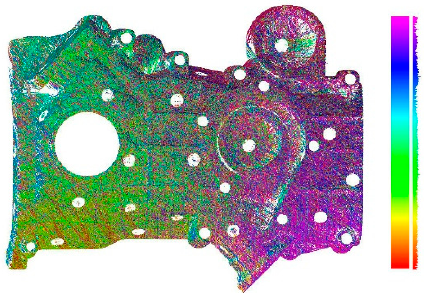
Figure 13. An example of input data of our algorithm; curves are displayed in different colors, and histograms of different color intervals are displayed on the right side.